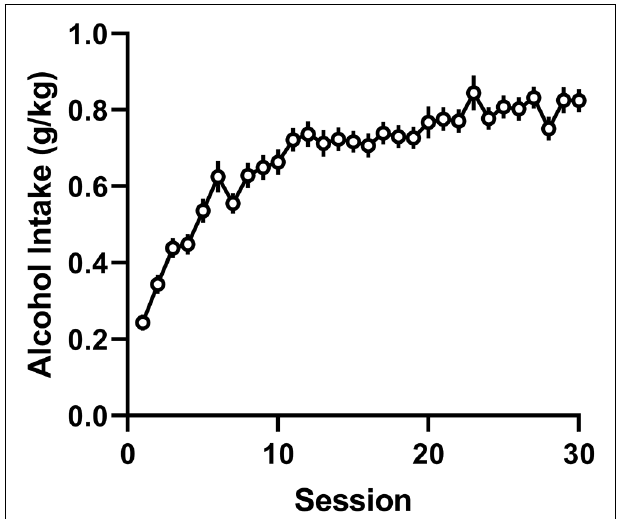
FIGURE 2 | Acquisition of alcohol drinking during intermittent 2-h sessions by alcohol-preferring Alko Alcohol (AA) rats. The data are depicted as mean ( ± SEM) alcohol intake (g/kg body weight in 2 h) over 30 sessions (10 weeks) by all animals included in the final data analysis ( n = 173).